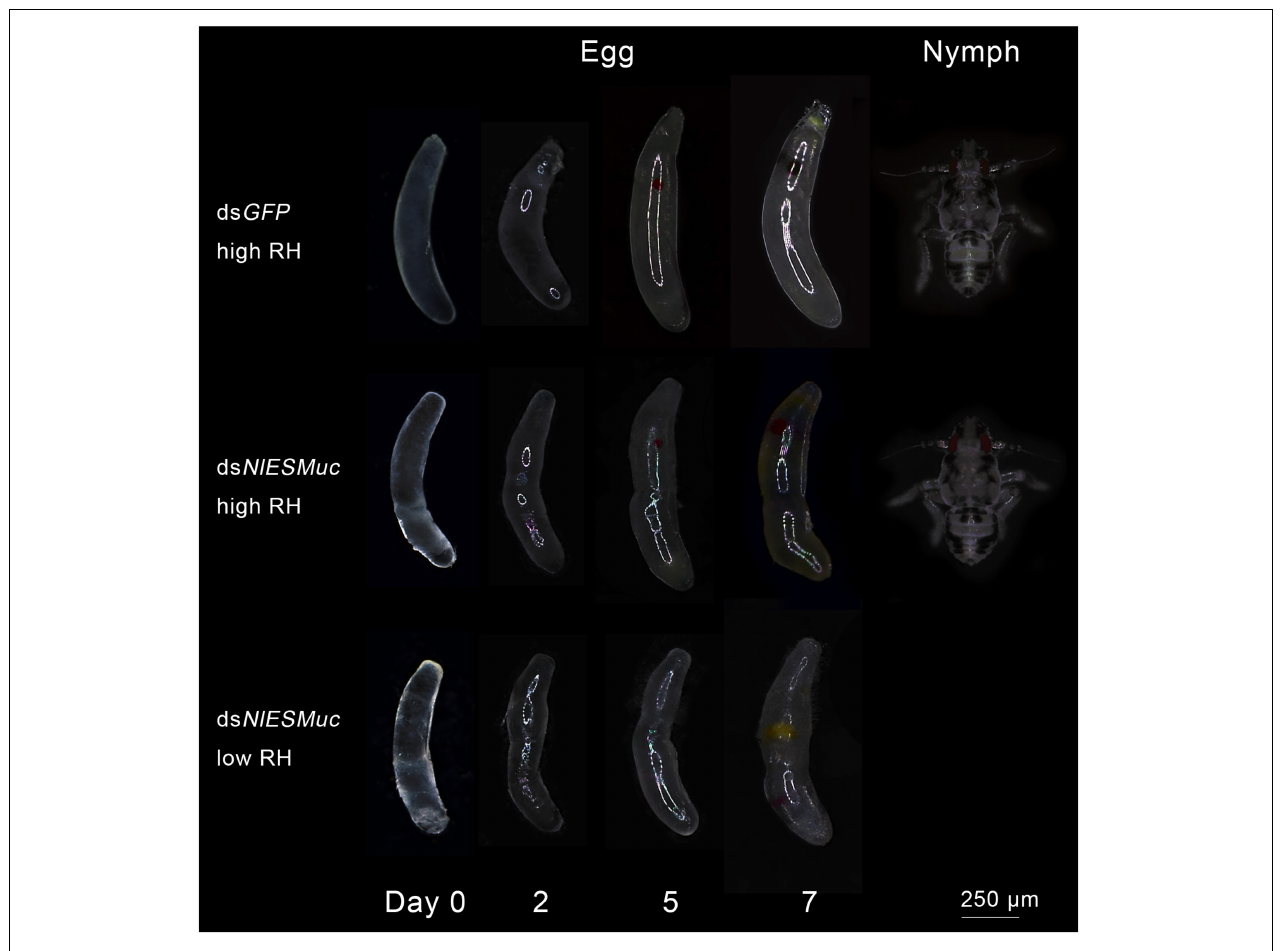
FIGURE 4 | Egg development in dsGFP (control) and dsNlESMuc groups. Different humidity levels were set, and each treatment contained 20 dsRNA-injected females. Normal BPH eggs were cylindrical and slightly curved, while the dsNlESMuc eggs dissected from the rice seedlings were irregularly shaped. dsNlESMuc eggs kept in 95–100% relative humidity could hatch successfully, but almost all dsNlESMuc eggs in 45–55% relative humidity failed to hatch. RH, relative